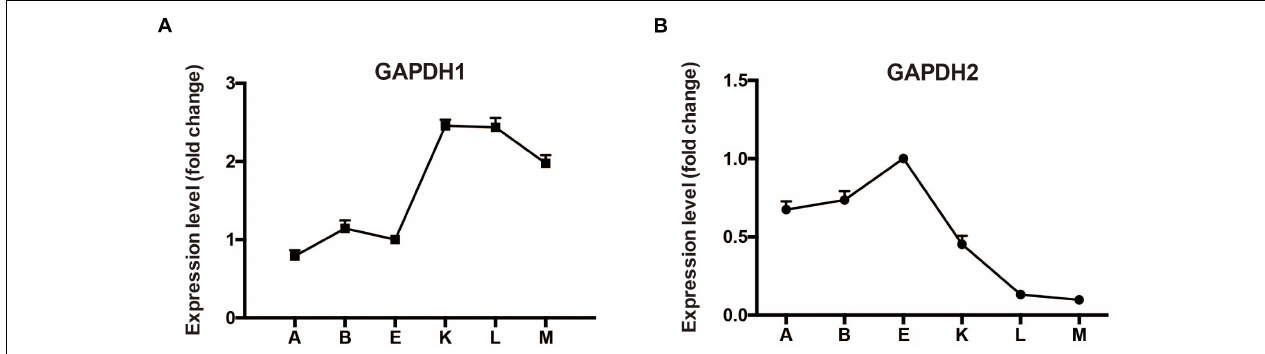
FIGURE 2 | Expression level of GAPDH during batch fermentation (A) expression level change of GAPDH1; (B) expression level change of GAPDH2. M. alpina was cultured in a 5 L fermenter and samples were collected at time points before and after the nitrogen exhaustion (sample A: –12 h, B: –2 h, E: –30 min, K: +1 h, L: +12 h, and M: +48 h). Three replicates were achieved for the flask fermentation.